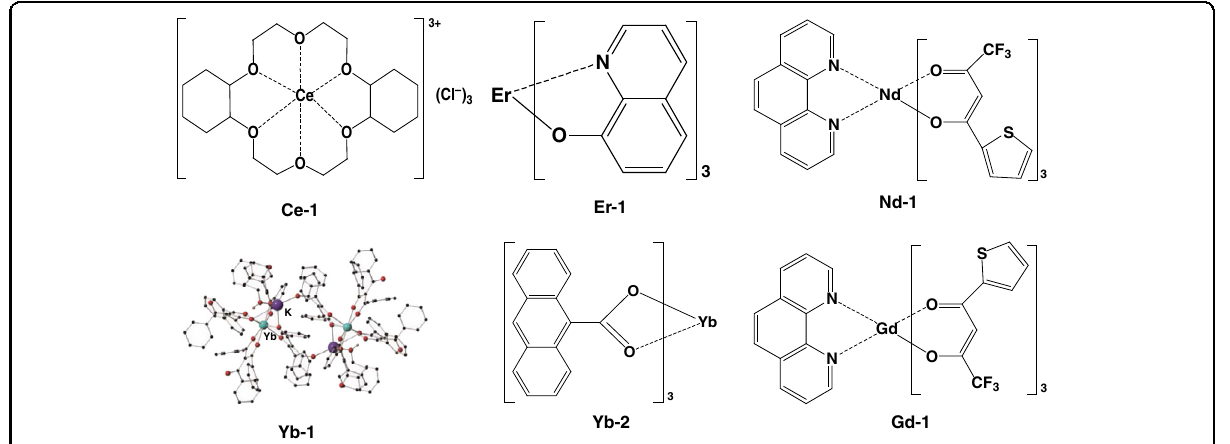
Fig. 9 The complex structures of Ce-1, Er-1, Nd-1, Yb-1, Yb-2 and